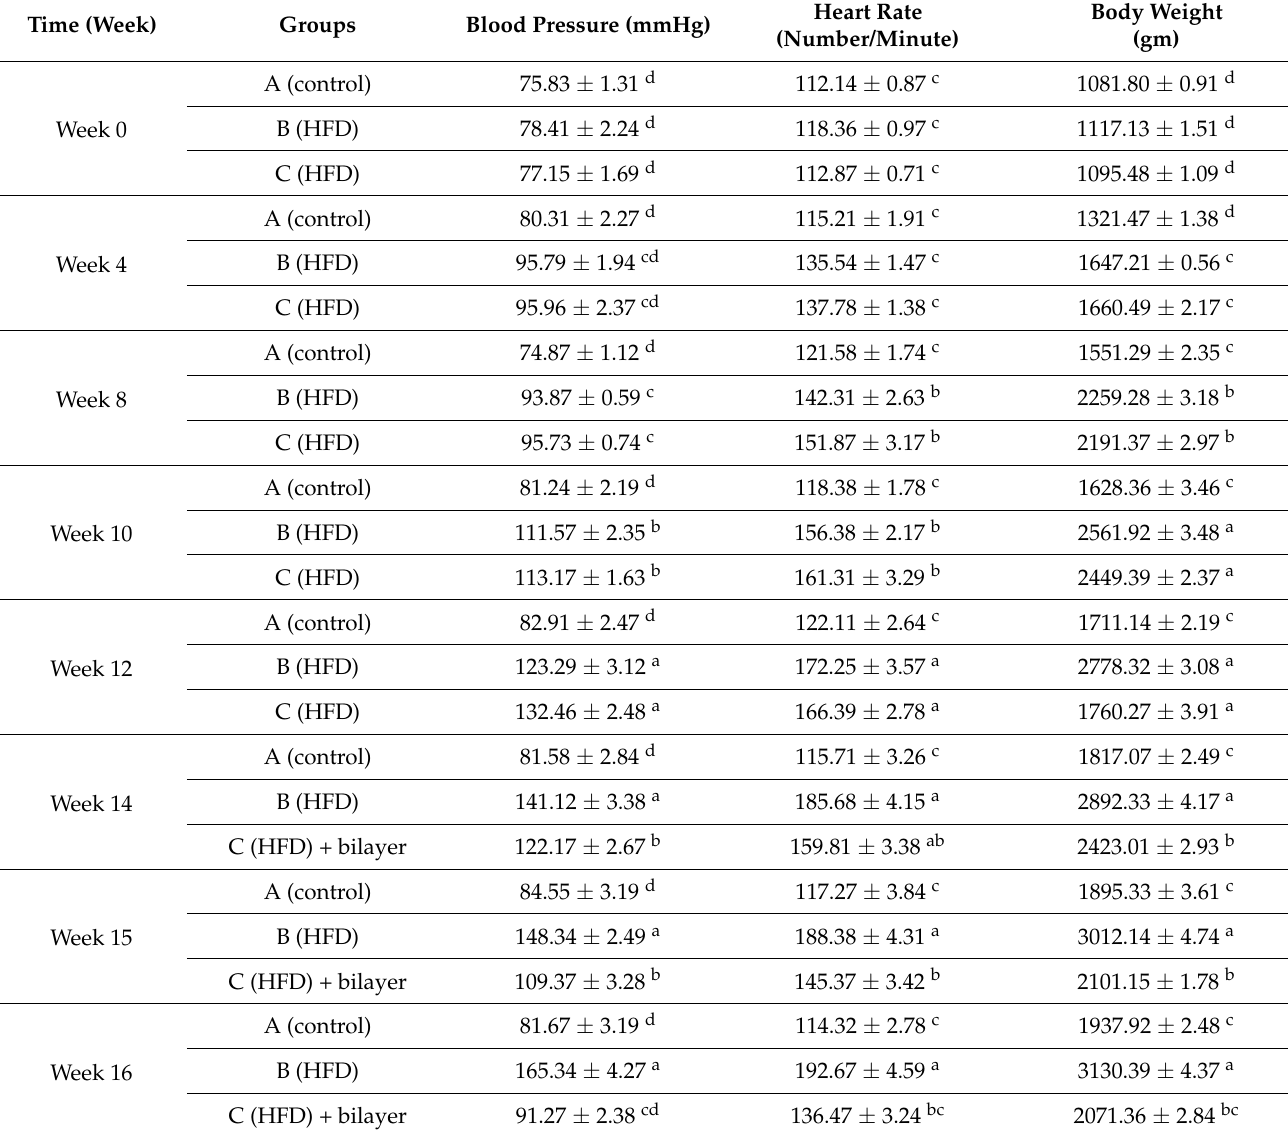
Table 12. Changes in the blood pressure, heart rate, and body weight (mean values ± SE, n = 3) in rabbits in all groups over all the experimental